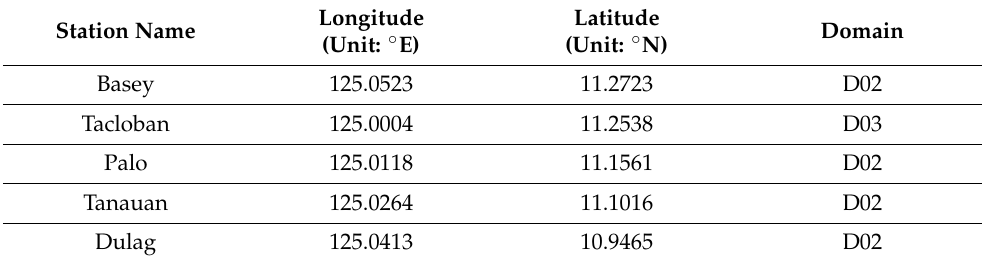
Table 3. Numerical gauge locations and their domain